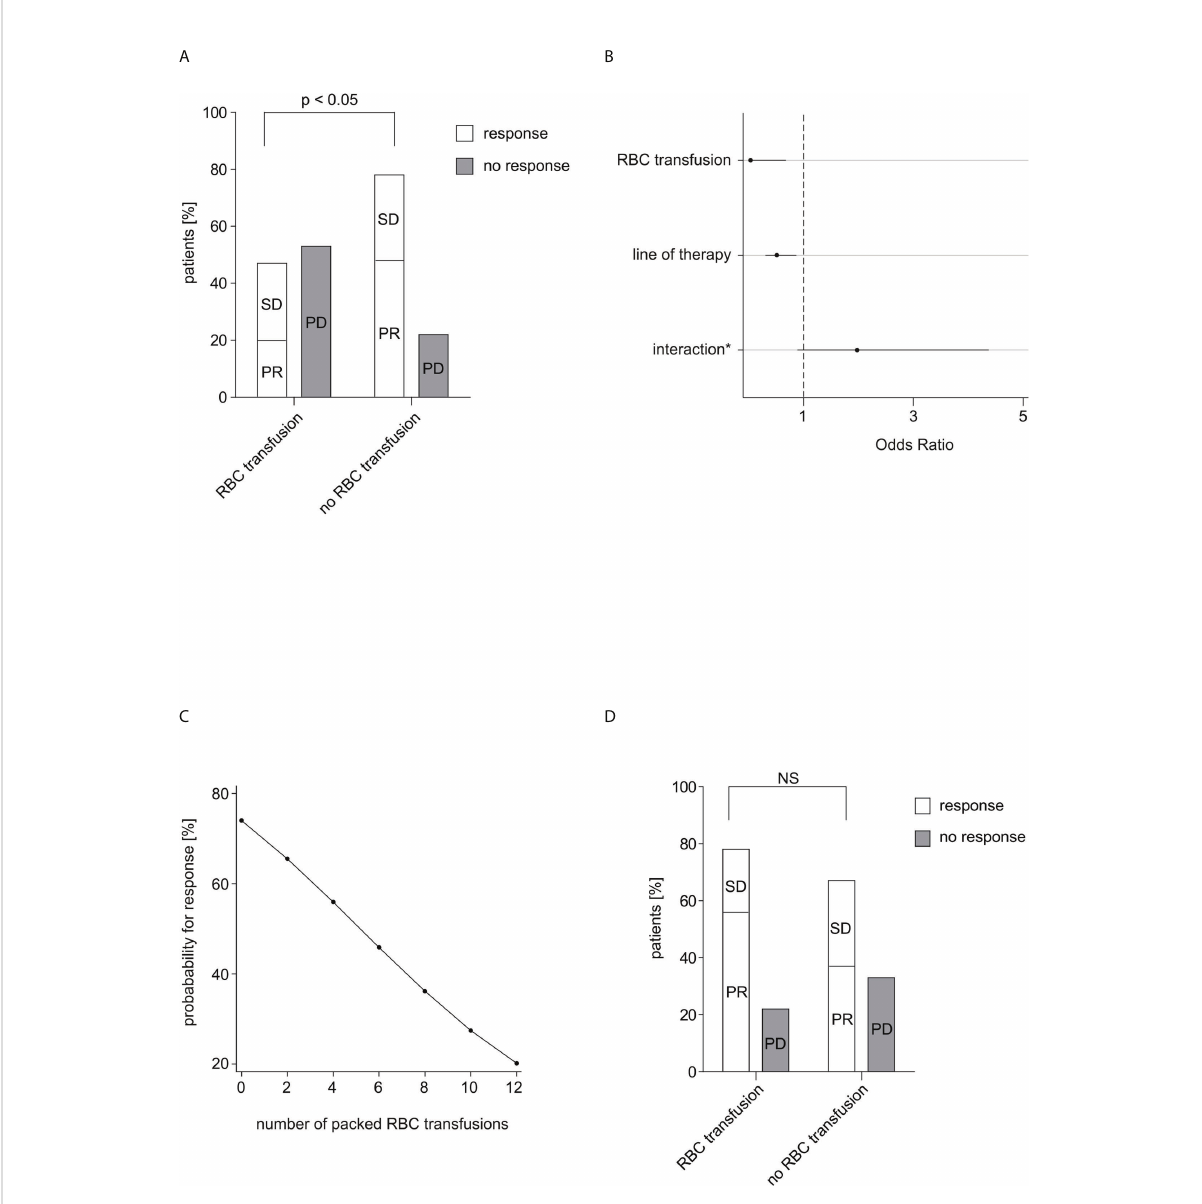
treatment within 30 days before start of IT was reported for 18 patients (32.7%). Infection rate was 28.3% in the non- transfusion group and 55.6% in the transfusion group (Figure 2B).